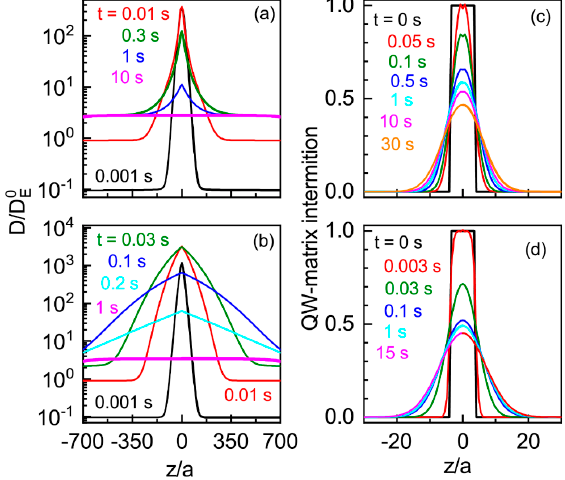
Figure 9. Dynamics of diffusivity factor ( a , b ) diffusion profiles of the quantum well ( c , d ). The diffusivity factor is normalized to its value D 0 , determined by the equilibrium concentration of neutral vacancies: ( a , b ) the case of the diffusion of interstitial atoms is close to that for vacancies; ( b , d ) the diffusion of interstitial atoms is much faster than that of vacancies.